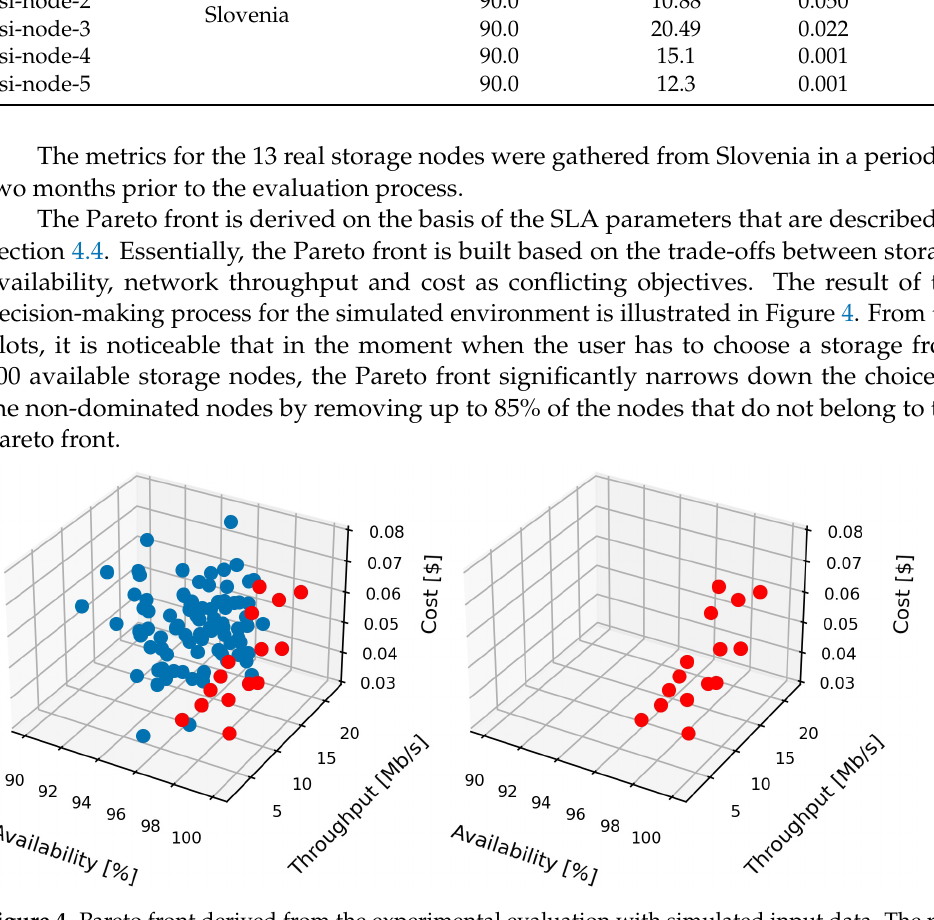
Figure 4. Pareto front derived from the experimental evaluation with simulated input data. The plot on the left illustrates all available Fog storage nodes, whereas the plot on the right illustrates only the non-dominated nodes that form the Pareto